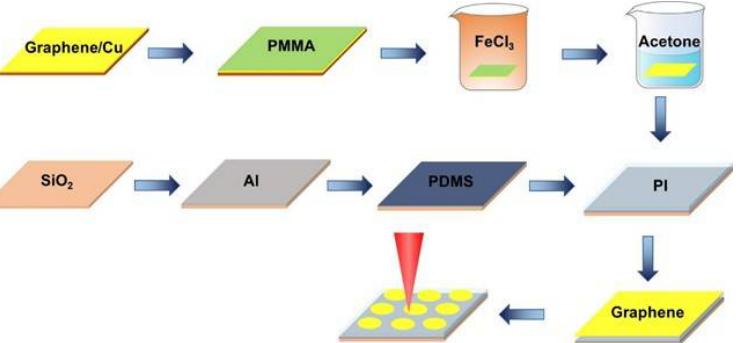
Figure 2. Preparation of graphene film and the proposed absorber based patterned graphene met-